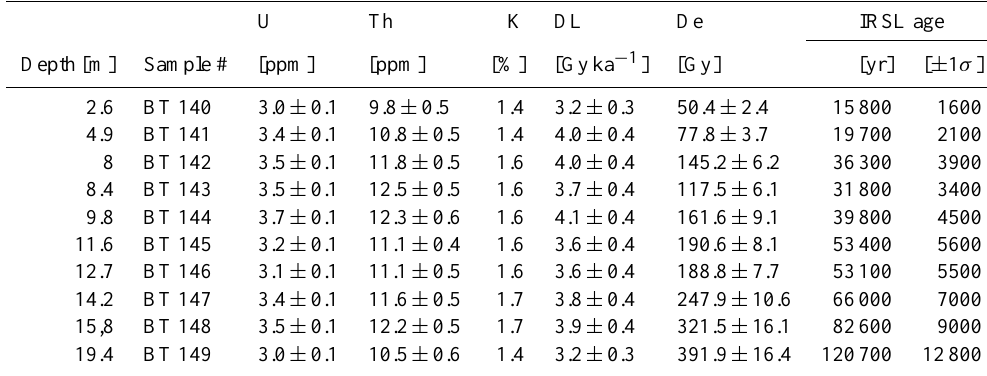
Table 1. Chronological data of the Surduk loess sequence: IRSL age determinations (Fuchs et al., 2008). The first two columns are for sample identification; columns 3 to 5 are for U, Th and K contents; columns 6 and 7 are for effective dose rate (DL) and equivalent dose rate (De); and last columns are for IRSL estimated age ( ± 1sigma). Further information in Fuchs et al. (2008).